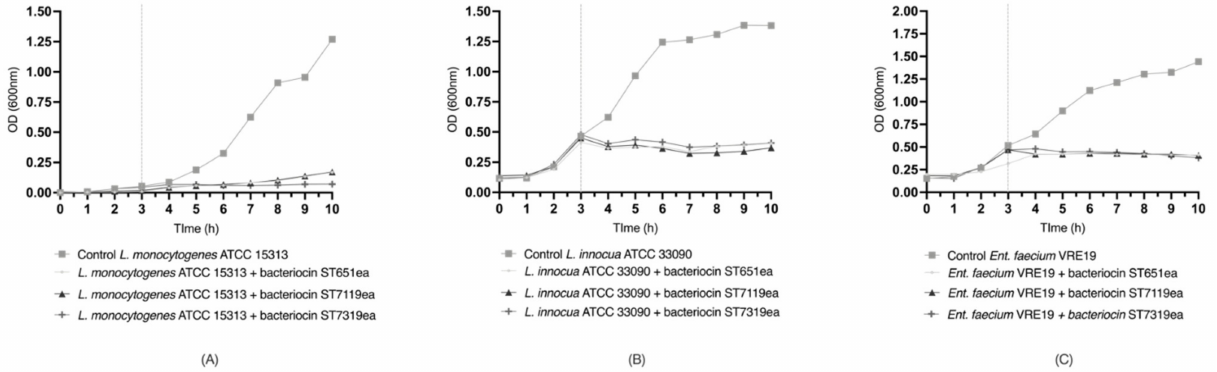
Figure 2. Bacterial growth inhibition of ( A ) L. innocua ATCC33090, ( B ) L. monocytogenes ATCC15313 and ( C ) E. faecium VRE19 by bacteriocins ST651ea, ST7119ea and